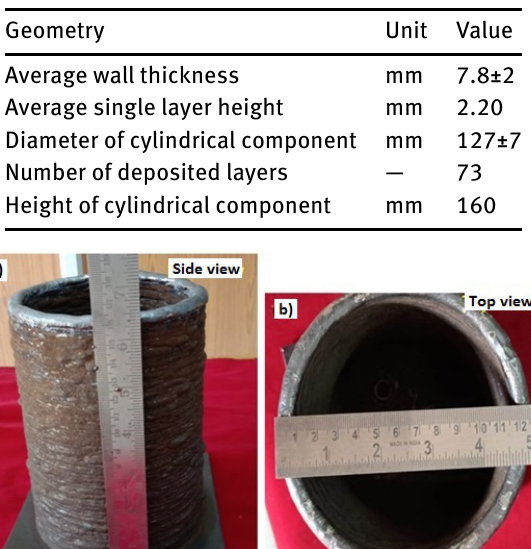
Figure 2: Schematic illustration of the steel cylindrical component a) indicating direction of deposition, b) showing separation of component in two regions (b-1(bottom region) and b-2(top region)) and c). extraction of samples from two regions. Table 4: Dimensions of manufactured cylindrical component.